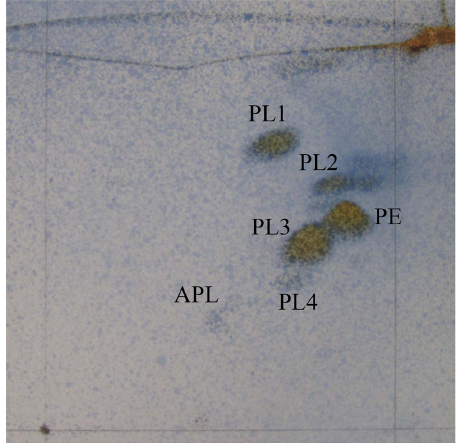
Figure 2. Polar lipids of the strain Pontibacterdiazotrophicus sp. nov. H4X T . PE, phosphatidylethanolamine; APL, aminophospholipid; PL1-4, unknown phospholipids.